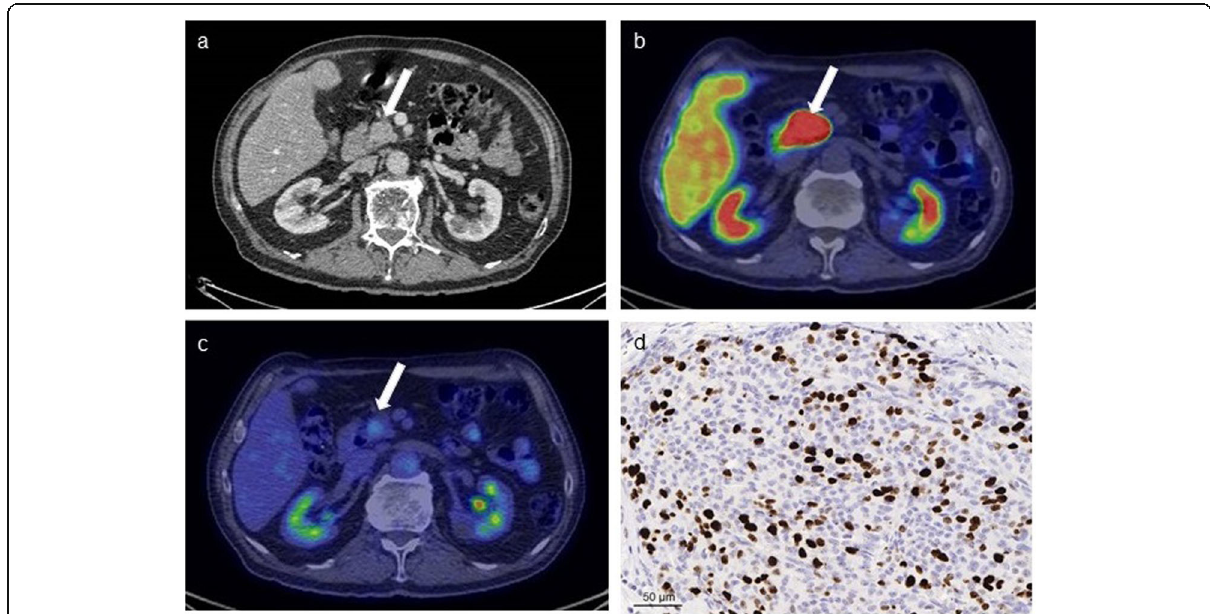
Fig. 4 An 80-year-old male patient had a 3 cm solid mass in the head of the atrophic pancreas on CT ( a ). 68 Ga-DOTANOC-PET/CT ( b ) showed intense uptake (SUV max 79 g/ml) and 18 F-FDG-PET/CT ( c ) was positive (SUV max 3.4 g/ml, higher than liver background). He underwent a pancreaticoduodenectomy and histopathological analysis revealed a well-differentiated G3 PNET (Ki-67 31 %) ( d , image magnification × 40)